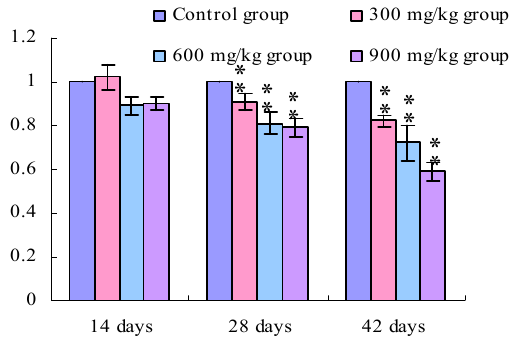
Figure 7. The TLR4 mRNA expression levels in the ileac mucosa in broilers.